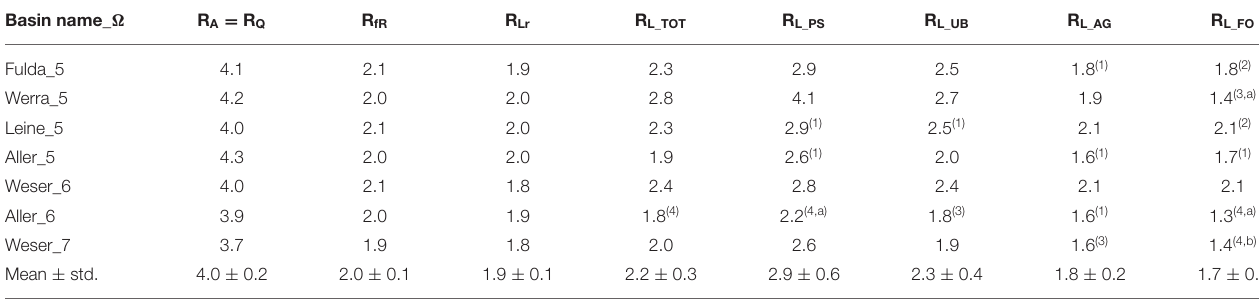
TABLE 2 | Hortonian scaling ratios for the Weser River Basin and six